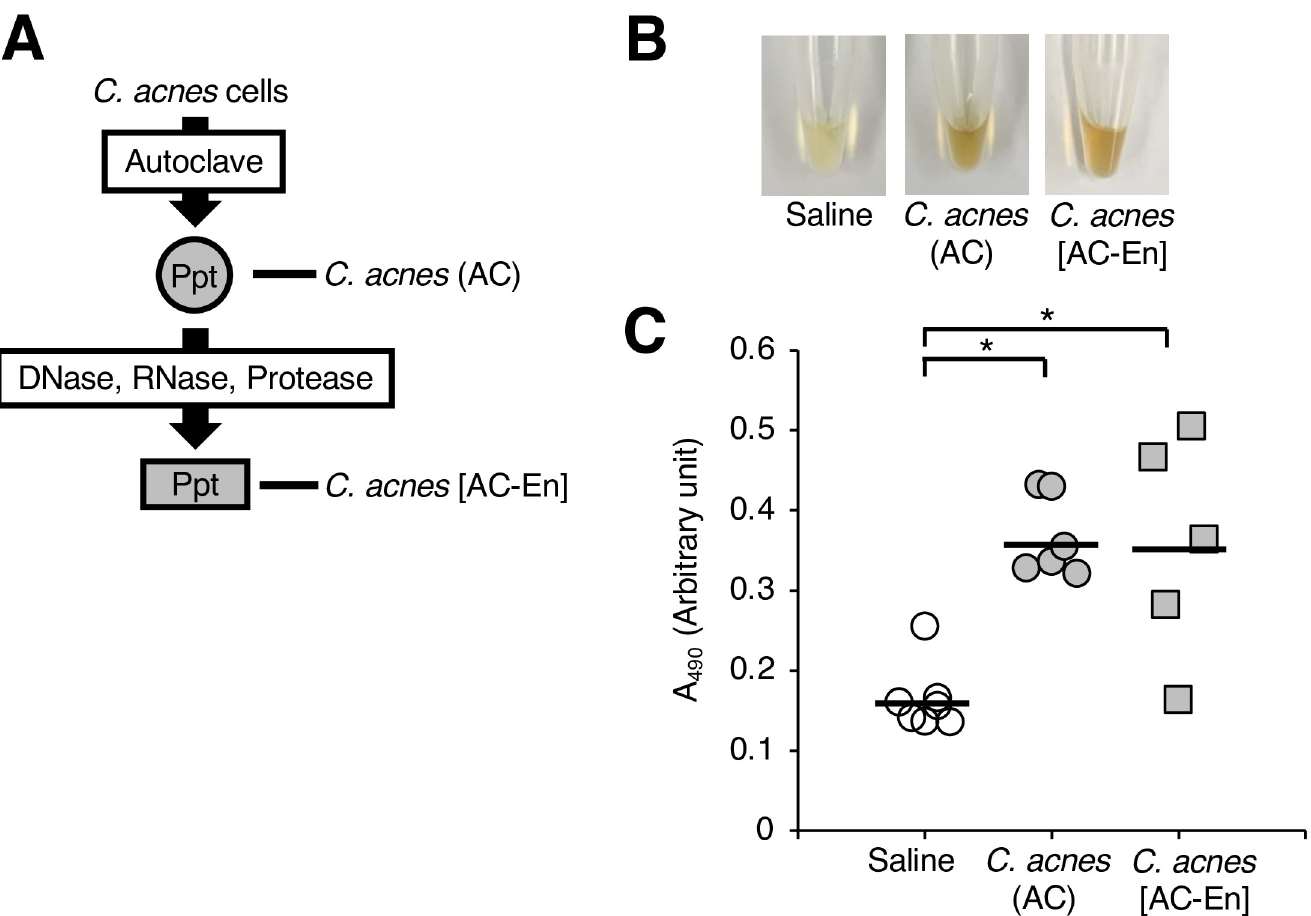
Fig 4. Effect of various enzyme treatments against the heat–killed C . acnes cells on their ability to induce melanization of the silkworm hemolymph. ( A ) Preparation of the enzyme–treated C . acnes (AC) fraction ( C . acnes [Ac–En]). The C . acnes (AC) fraction was treated with DNase, RNase A, and protease K. ( B , C ) Silkworms were injected with 50 μ l of saline (Saline), the autoclaved C . acnes cell suspension ( C . acnes [AC]), or the enzyme–treated C . acnes (AC) fraction ( C . acnes [Ac–En]). After incubation for 3 h at 37˚C, the silkworm hemolymph was collected. Photographs of the silkworm hemolymph were taken ( B ), and absorbance at 490 nm (A 490 ) ( C ) was measured. The arbitrary unit was defined as the absorbance at 490 nm of a sample of silkworm hemolymph (50 μ l) mixed with saline (50 μ l). n = 5–7/group. Statistically significant differences between groups were evaluated using the Tukey–Kramer test. � P < 0.05.